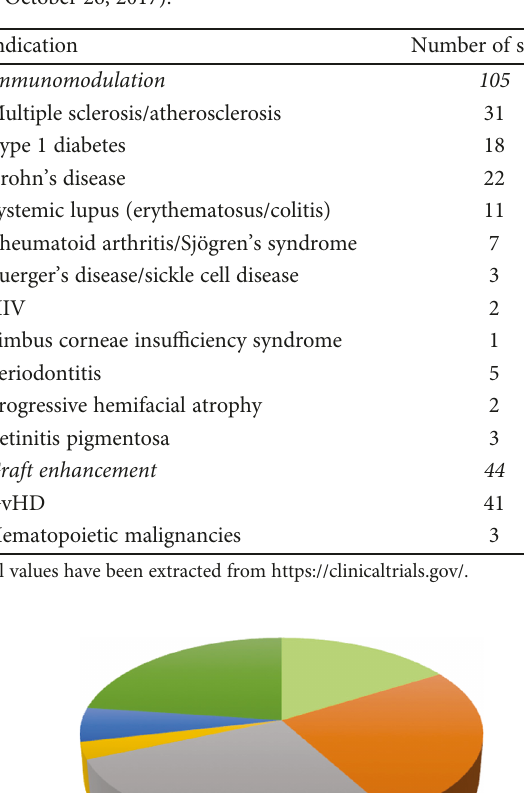
Table 3: Clinical trials using mesenchymal stem cells (registered as of October 26, 2017).